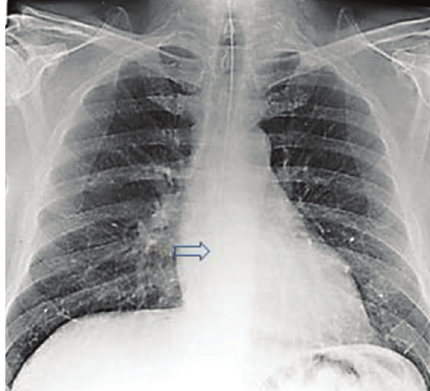
Figure 30: A CXR showing the tip of the NGT in the mid/lower esophagus. And it shows a portable chest radiograph on an intensive care patient that developed pleural e ff usions. A chest drain was placed to drain the left-sided pleural e ff usion. Bright red blood was obtained from the tube. A CT scan (Figure 28) obtained immediately revealed the tip of the catheter had entered the left ventricle. The patient was immediately taken for cardiac surgery and the tube removed without complications.